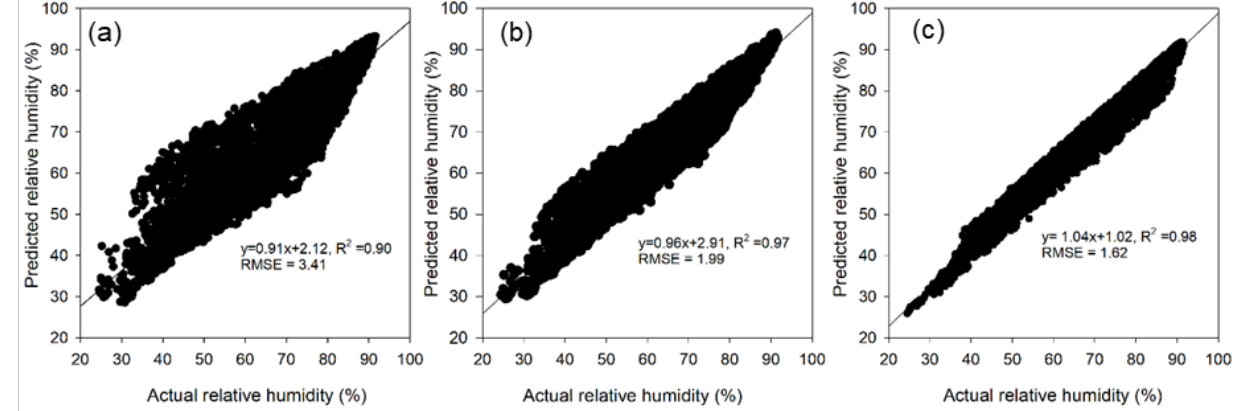
Figure 5. Training results for the three humidity prediction models (( a ) Model-1; ( b ) Model-2; ( c ) Model-3).